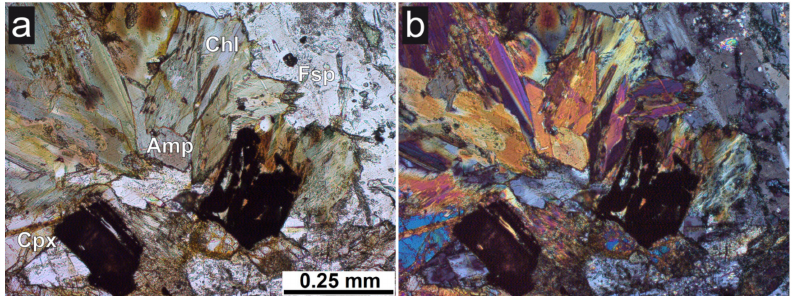
Figure 1. Photomicrographs of sample B1 in thin section. ( a ) and crossed nicols (B) a: Amphibole (Amp) and chlorite (Chl) showing greenish colors and pleochroism, clinopyroxene (Cpx) and feldspar (Fsp) are also major phases. ( b ): Under crossed polarizers, the low interference colors of the feldspars (plagioclase, grey) and the chlorite (anomalous bluish grey) become visible. Chlorite mainly forms